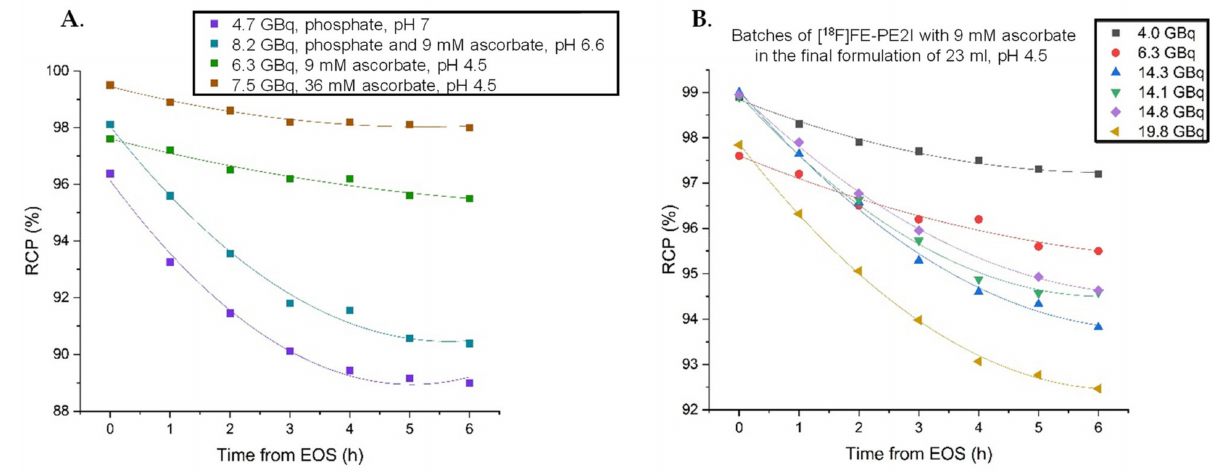
Figure 4. ( A ) Stability studies of the formulated [ 18 F]FE-PE2I in different buffers, at different concentrations and pH. ( B ) Stability of [ 18 F]FE-PE2I in 23 mL of the optimized formulation buffer over 6 h with different amounts of activity.